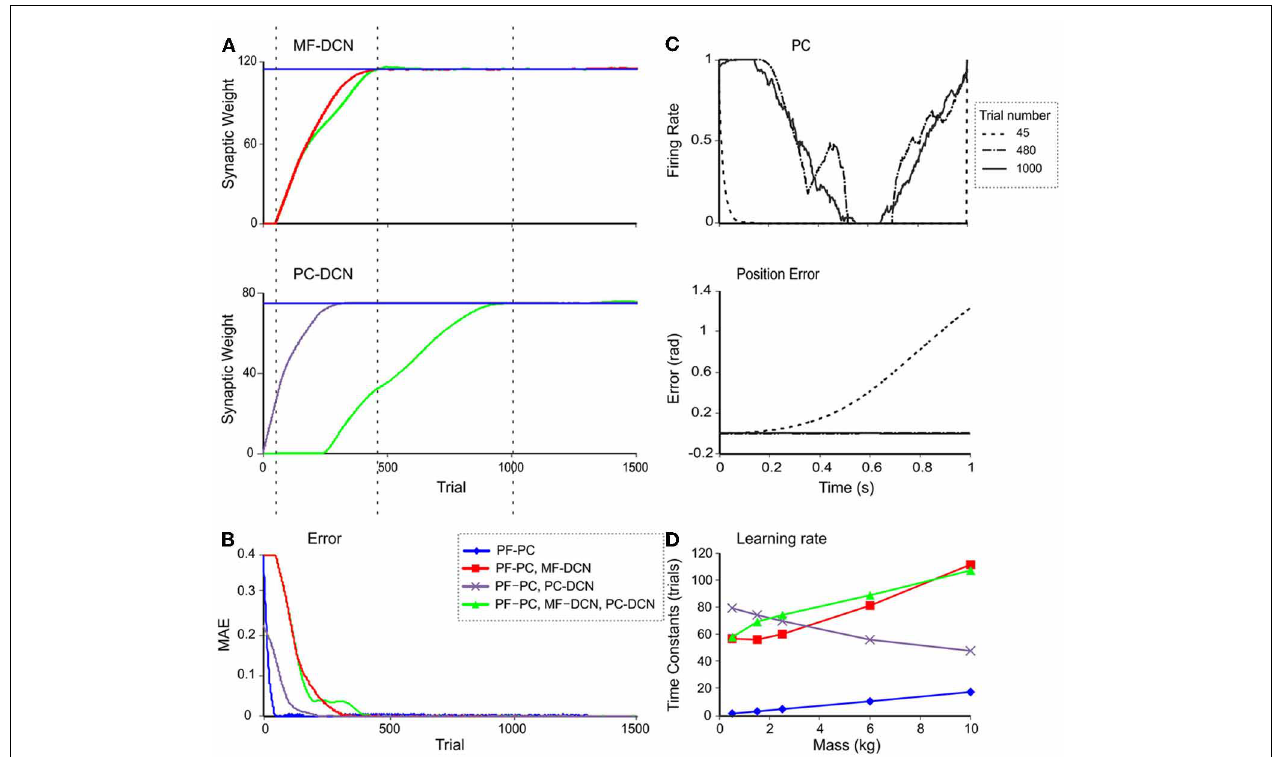
FIGURE 9 | Double time-scale learning. (A) Evolution of MF-DCN synaptic weight (top) , and PC-DCN synaptic weight (bottom) during the learning process when a 10-kg payload is being manipulated. (B) Evolution of MAE in the same trials as in A. (C) PC firing rate (top) and actual position error (bottom) in joint 2 at three different times: after 45 trials (gray line) , 480 trials (yellow line) , and 1000 trials (green line) . (D) Time constants of the fitted